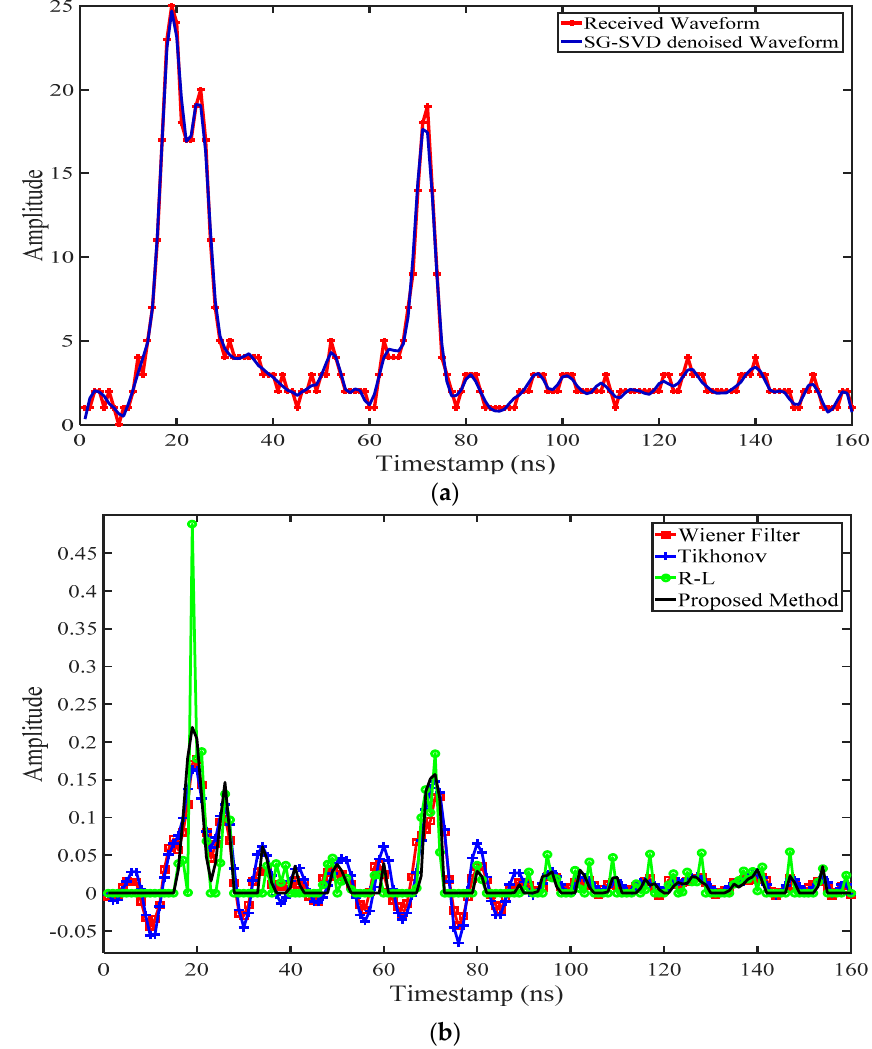
Figure 11. ( a ) Raw received waveform and its noise-reduced version; and ( b ) the recovered differential cross-sections for different methods.